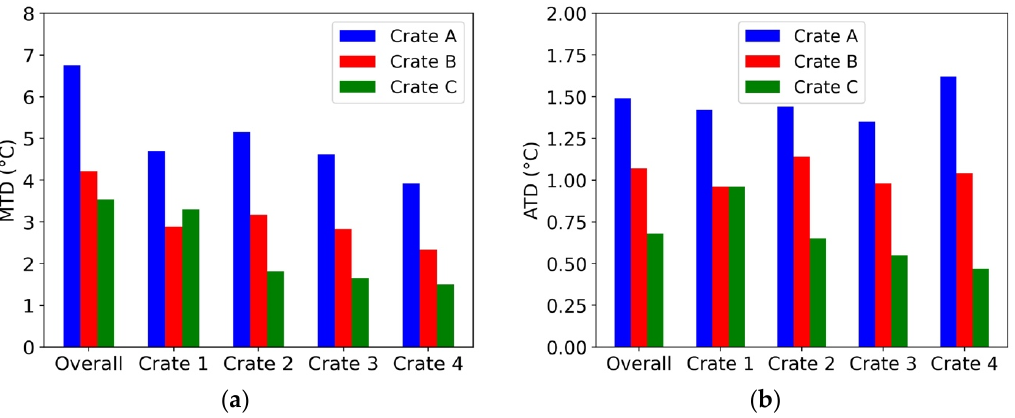
Figure 18. Influence of crate design on ( a ) the maximum temperature difference and ( b ) the average temperature difference between the products at the pallet layer and crate levels.